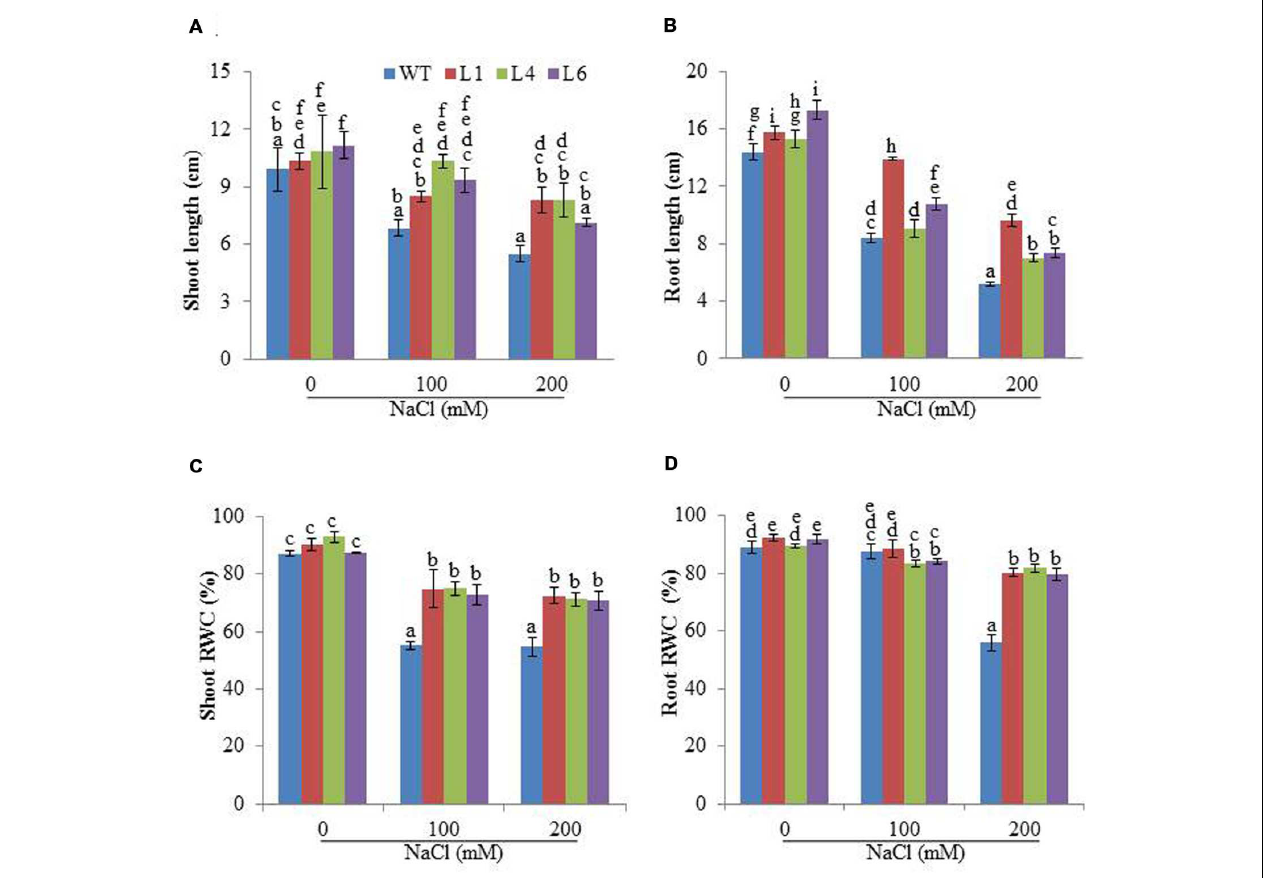
FIGURE 3 | Physiological changes in JcPR-10a transgenic plants grown in the presence of 0, 100, and 200 mM NaCl. (A,B) Shoot and root length, (C,D) Relative water content (RWC) of shoot and root. Values represented are means ± SE ( n = 3) and marked with different alphabets to indicate significant difference at P ≤ 0.05